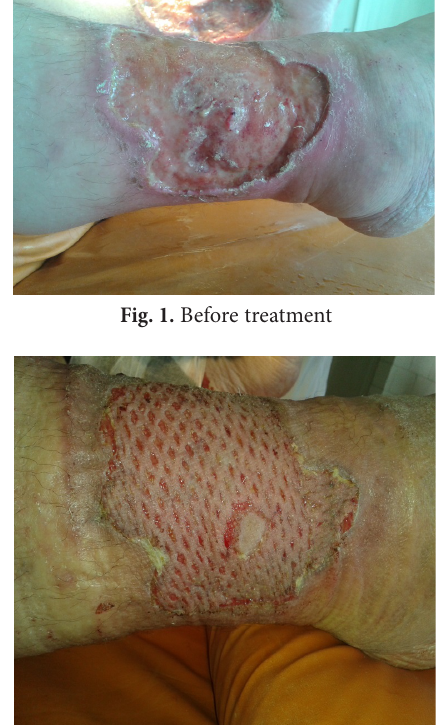
Fig. 2. After shave-therapy, skin grafting, NPWT 3 days and extract from hospital